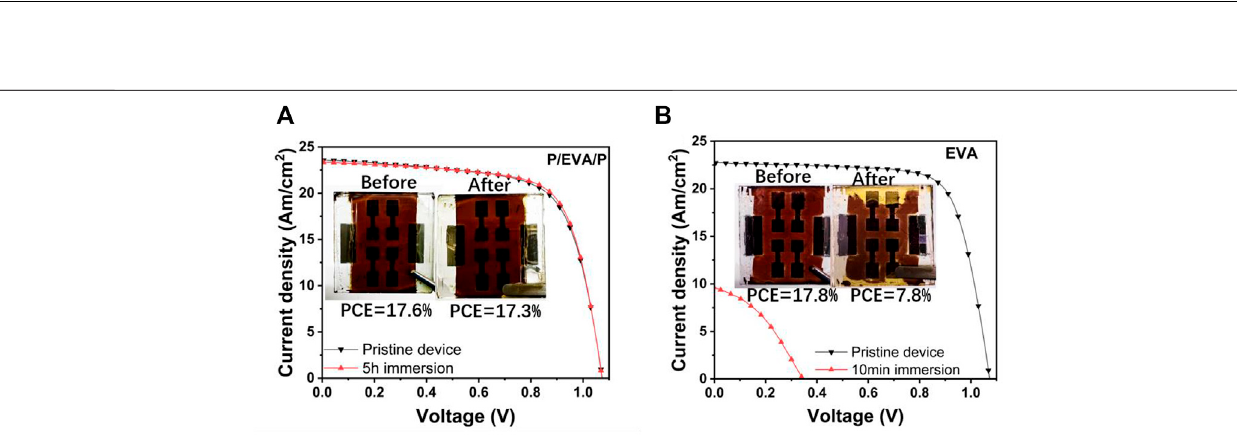
Frontiers in Materials |